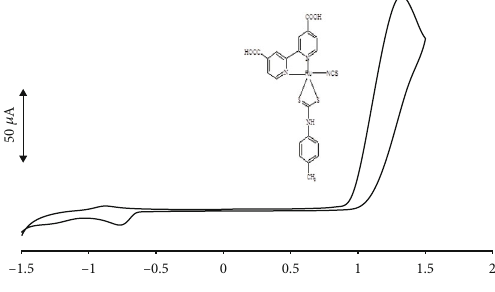
Figure 4: Cyclic voltammogram of FC